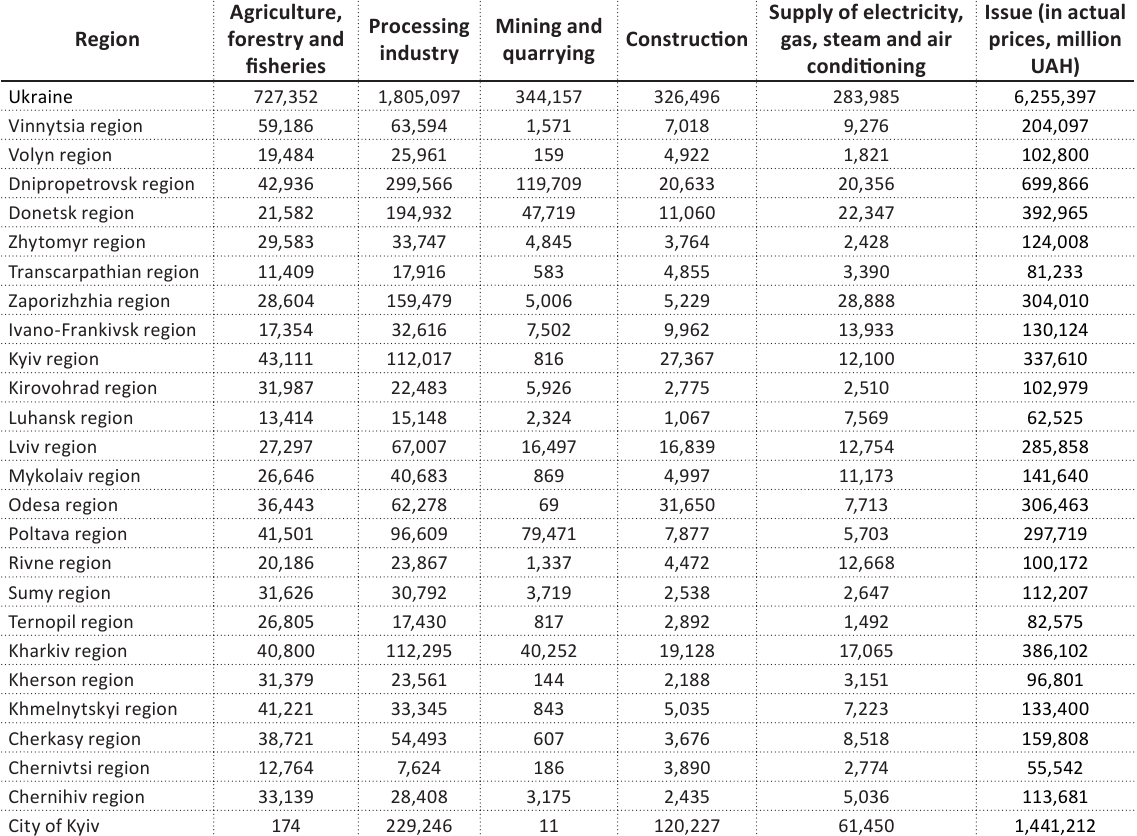
Table 3. Indicators of assessment of the production component of the economic potential of the Ukrainian territories by branches of material production in 2017, mln